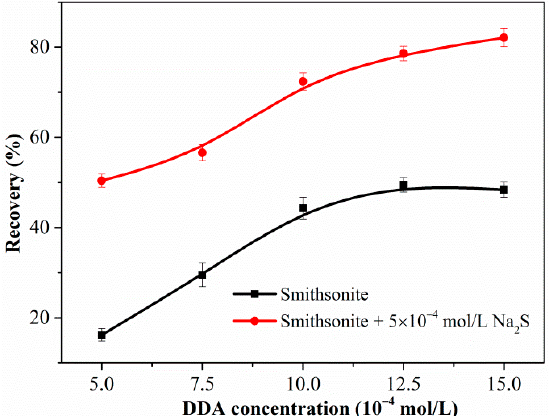
Figure 2. Flotation recovery of smithsonite as a function of DDA concentration in the absence or presence of Na 2 S at pH 10.3.